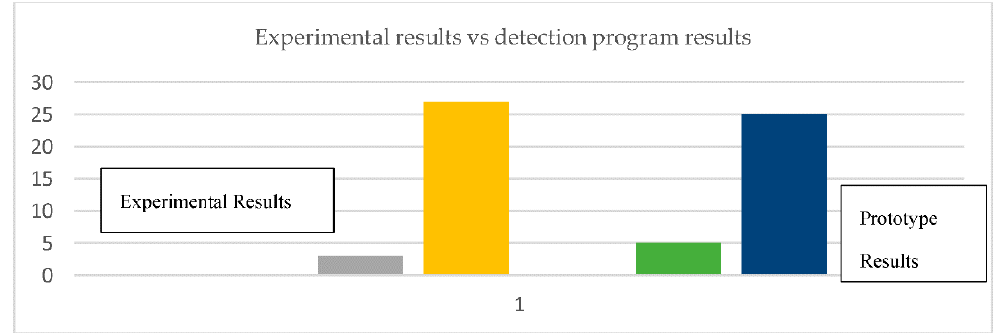
Figure 22. Experimental results vs. detection program results.